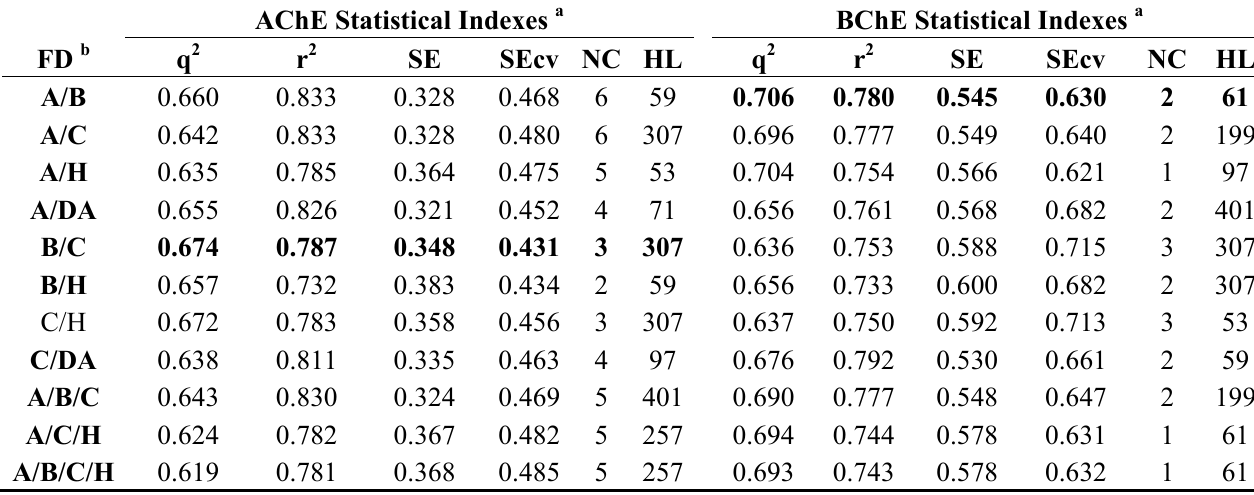
Table 2. Summary of HQSAR statistical indexes for various fragment distinction (FD) parameters using the fragment size default (4–7) for both AChE and BChE inhibitors.